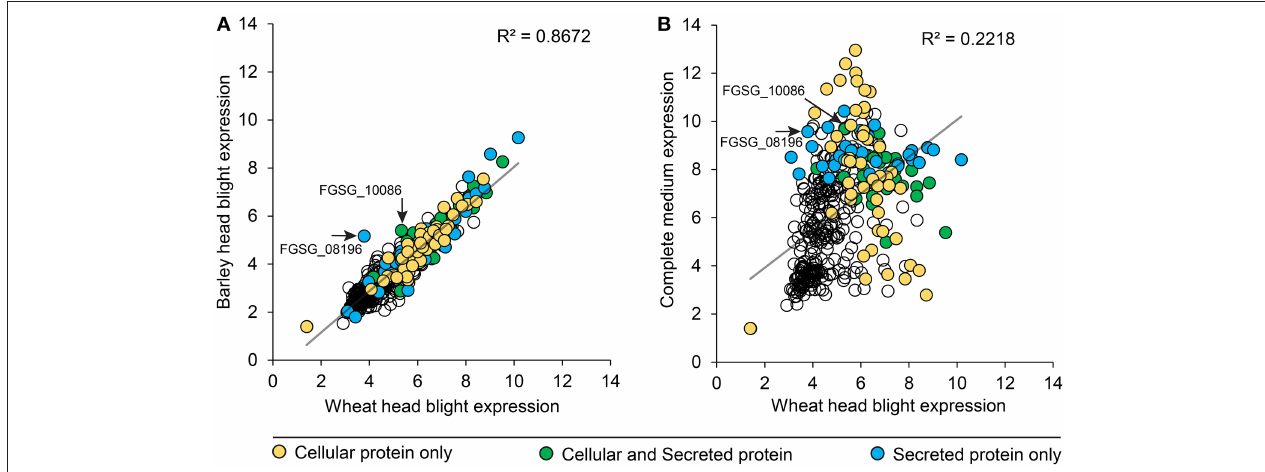
FIGURE 6 | Peptidase gene expression in wheat, barley and complete medium. F. graminearum peptidase gene expression (RMA values) from microarrays of barley and wheat head blight disease (A) were plotted to reveal the degree of transcriptional gene co-regulation on the two different host plants. Two peptidases that were differentially reguated between the two in planta conditions are indicated with an arrow and label. For comparison, gene expression (RMA values) from in vitro growth on complete medium were compared to wheat head blight (B) . The secretion status determined from proteomics analyses is displayed in the shading of each peptidase value: yellow for cellular proteins, green for proteins found in both the cellular and secreted proteomes, and blue for proteins only found in the secreted proteome.